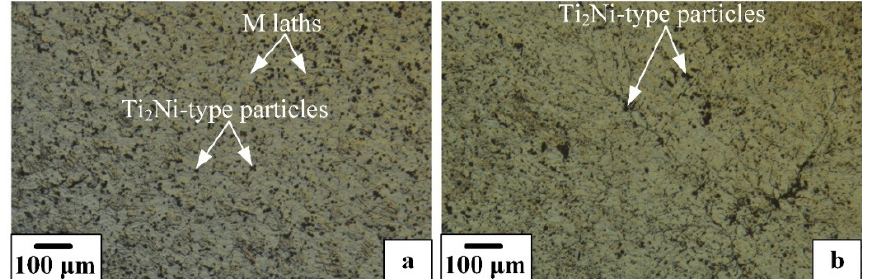
Figure 4. Microstructure of the TiNiHf SMA rods with a diameter of 3.5 mm after RF ( a ) and RF + PDA 550 °C for 2 h ( b ). Light optical microscopy.